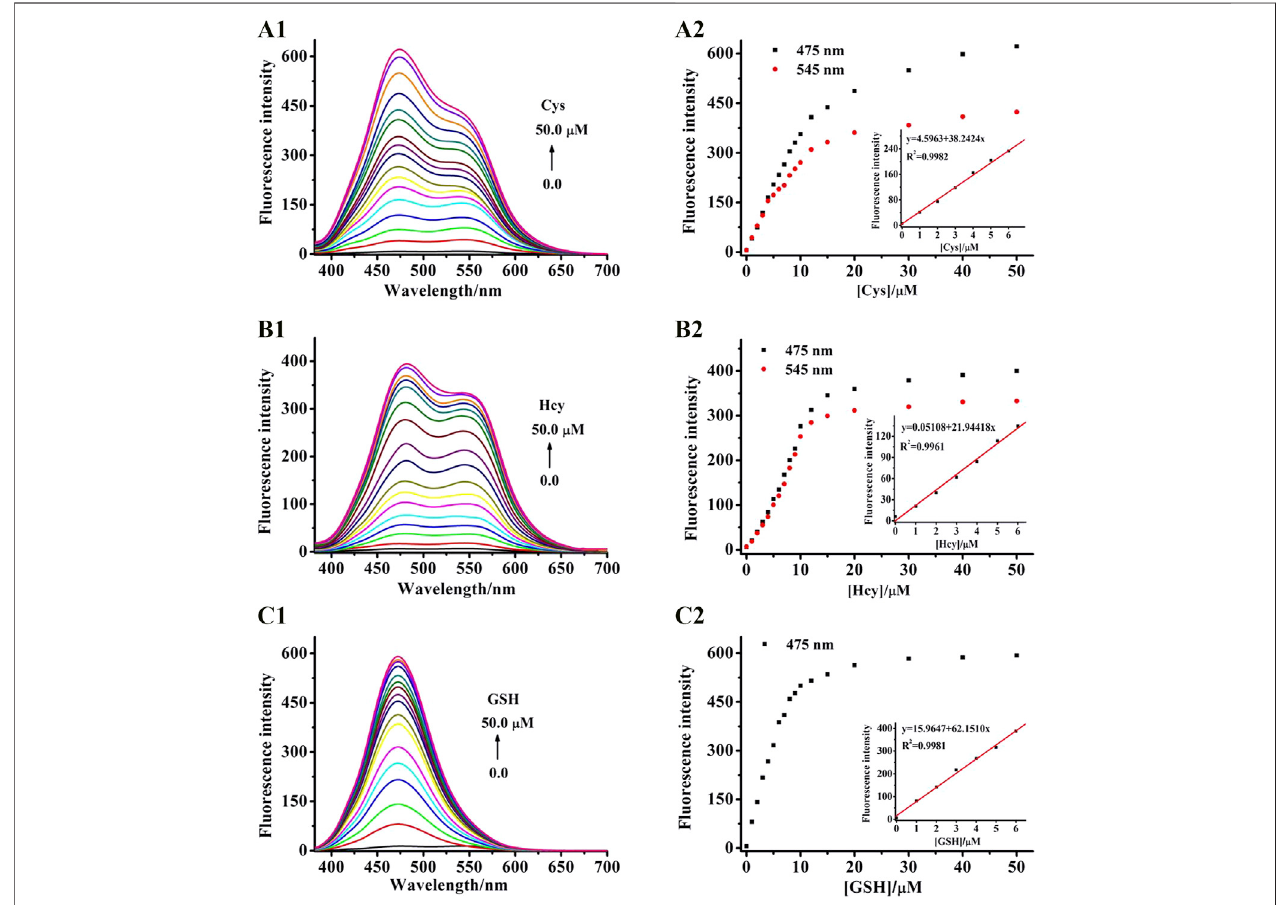
FIGURE 1 | (A1 – C1) Fluorescence response of BPN-NBD different Cys/Hcy and GSH concentrations in the 0.0 – 50.0 μ M range (pH 7.4 PBS buffer), respectively. (A2 – C2) Calibration curve of BPN-NBD vs. the concentrations of Cys/Hcy or GSH, and the linear relationship between fl uorescence intensity at 475 nm of BPN-NBD (10.0 μ M) and Cys/Hcy or GSH (0.0 – 6.0 μ